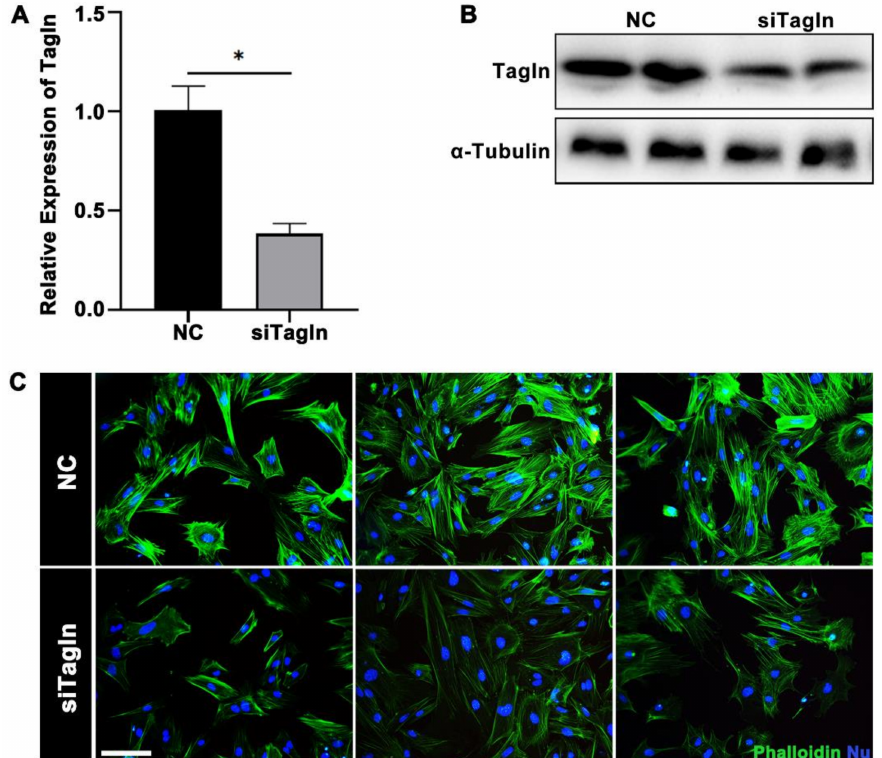
Figure 8. Reduced F-actin polymerization after transfected siTagln in SMCs. ( A , B ) RT-qPCR and western blot were used to detect the interference efficiency of Tagln in mice uterine SMCs on day 3 of pregnancy, * p < 0.05. ( C ) Phalloidin staining (green) after siTagln transfection, triplicate results. Scale bars = 200 µ